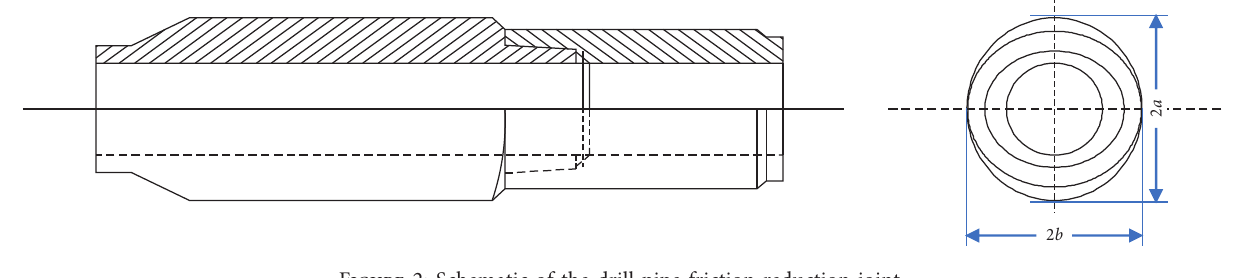
Figure 2: Schematic of the drill pipe friction reduction